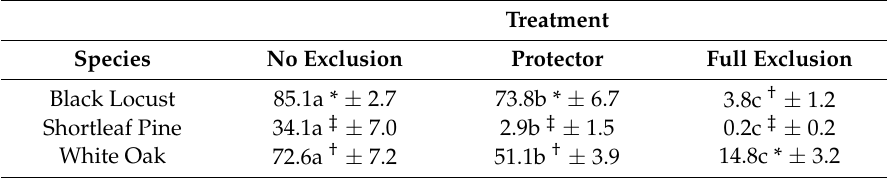
Table 3. First-year mammal herbivory incidence (%; Mean ± SE) among tree species and exclusion treatments on reclaimed mined lands in southeastern Kentucky. Means with differing letters indicate significant differences among exclusion treatments within a species, and means with different symbols indicate significant differences among species within an exclusion treatment, as determined via Type III ANOVA and subsequent Tukey-corrected pairwise comparisons at a 0.05 significance level.